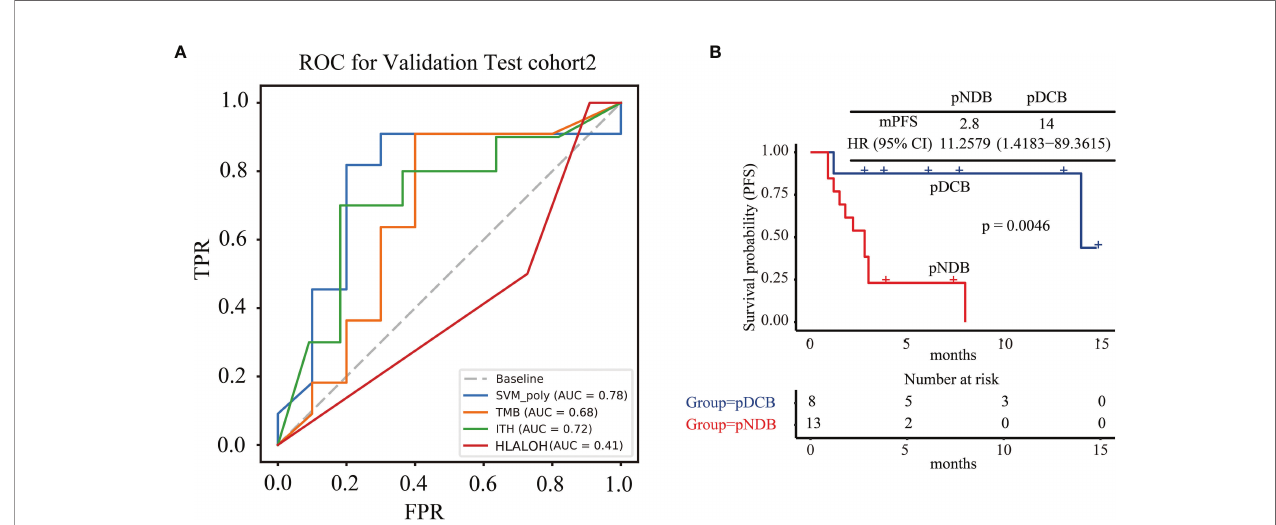
FIGURE 4 | The multi-feature model could effectively predict response to ICIs treatment in test cohort2. (A) ROC curves for multi-feature model, TMB, ITH, and HLA LOH in test cohort2. (B) Kaplan – Meier curves of PFS comparing pDCB with pNDB in test